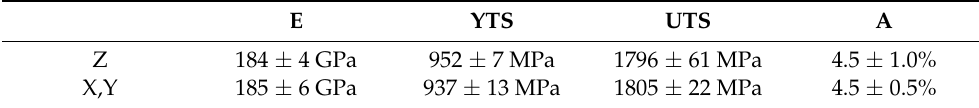
Figure 6. Stress–strain curves of tensile test of PBF-EB processed X37CrMoV5-1 tested in build direction (N = 7). Table 4. Tensile properties of the X37CrMoV5-1 PBF-EB specimen.